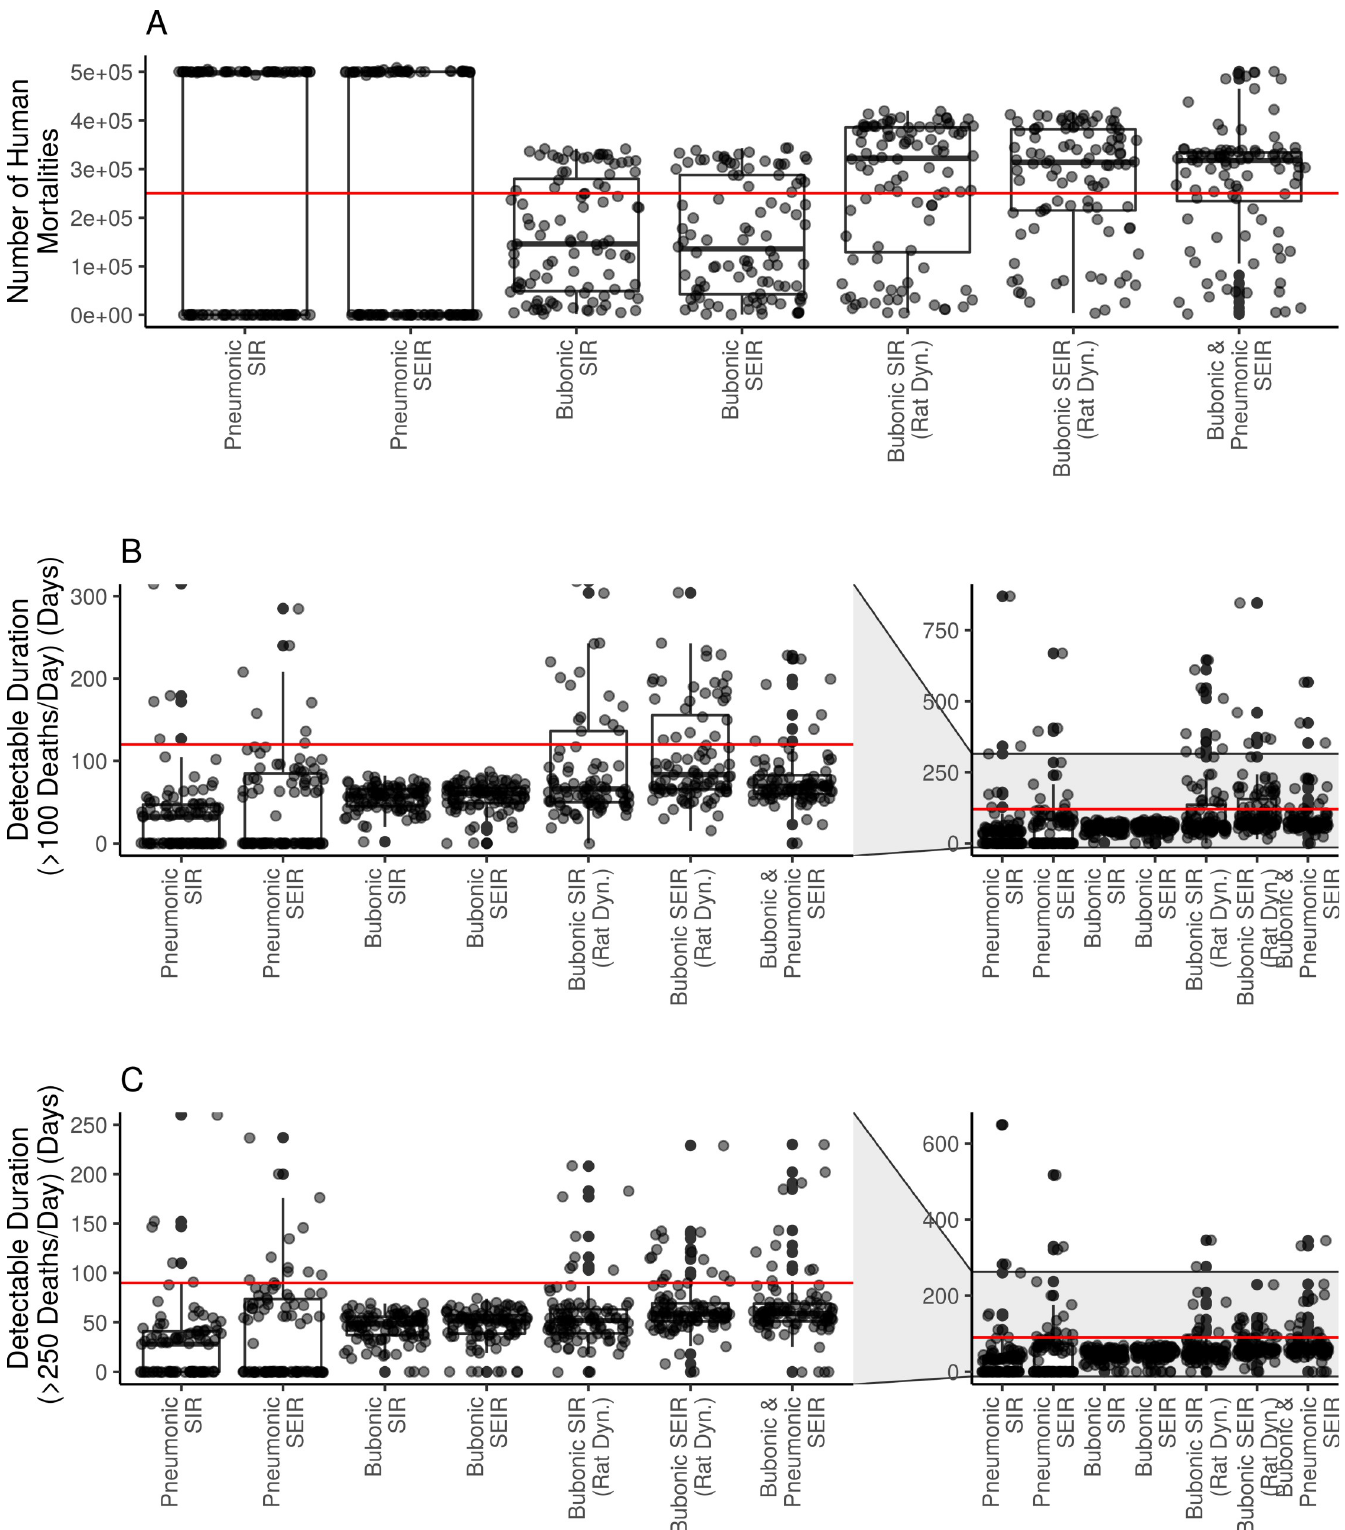
Fig 2. Box and whisker plot showing results of uniform LHS sampling. (A) number of human mortalities; (B) detectable outbreak duration ( > 100 deaths per day, non-consecutive) with inset including outliers (up to 5000 days); and (C) detectable outbreak duration ( > 250 deaths per day, non-consecutive) with inset